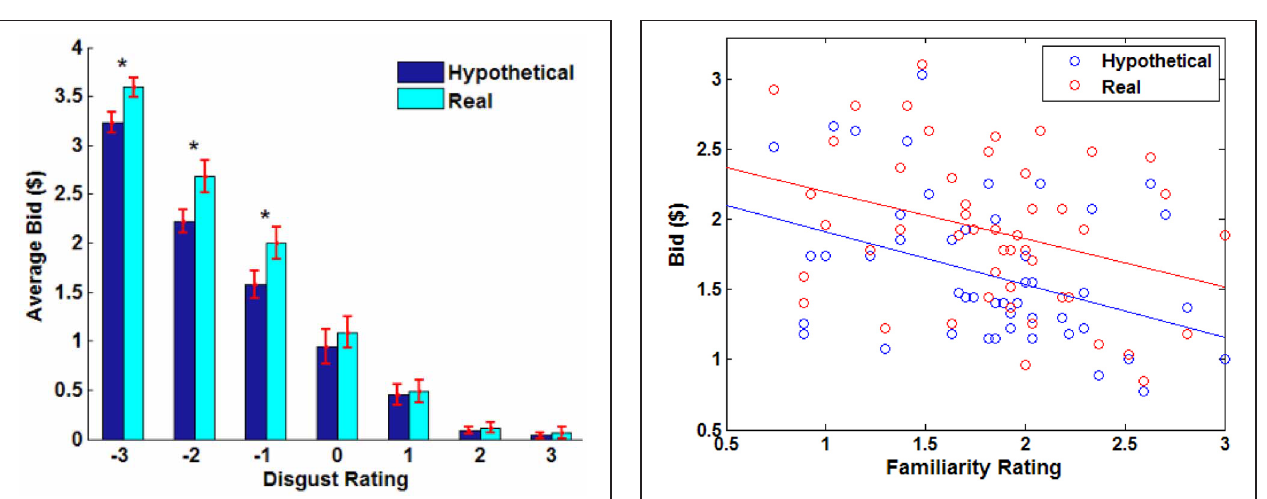
FIGURE A1 | Average bid as a function of disgust rating ( − 3: very disgusting; 0: neutral; 3: very appetitive) by trial type. Paired sample t -test, * p < 0 . 02, no asterisk = not significant.